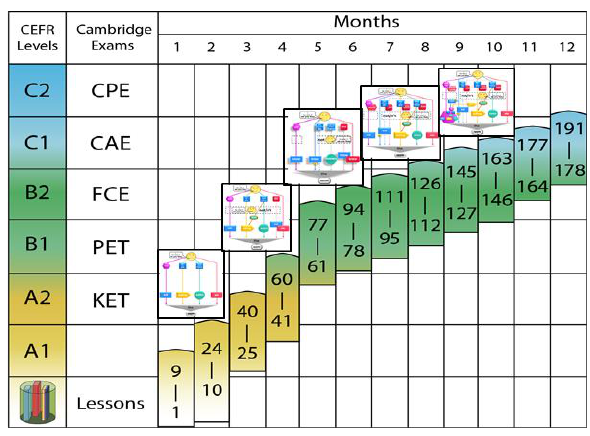
Fig. 7. Approximate order of use of Visual Models in accordance with the learning curve.